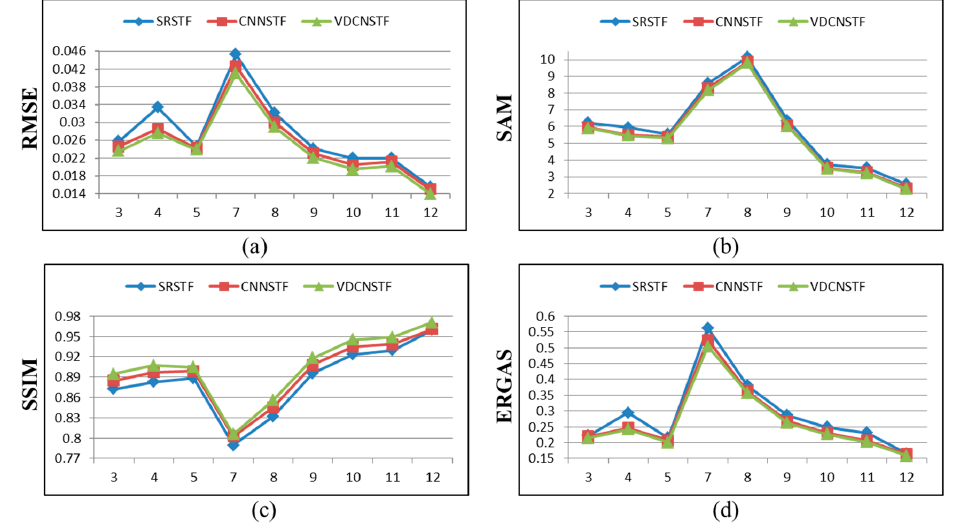
Figure 5. Quantitative results of 9 prediction dates at the LGC site: ( a ) RMSE; ( b ) SAM; ( c ) SSIM; ( d )